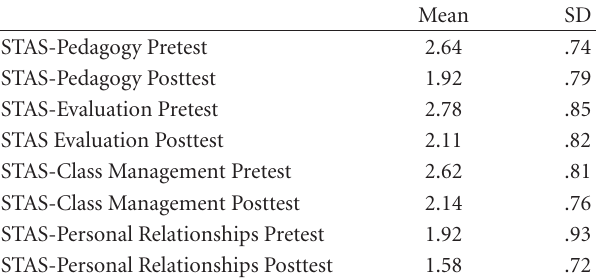
Figure 1: Showing the decrease in anxiety over time for each scale, and the more dramatic decrease in anxiety with respect to pedagogy and evaluation. Table 2: Means and standard deviations for four anxiety scales (STAS) at pretest and